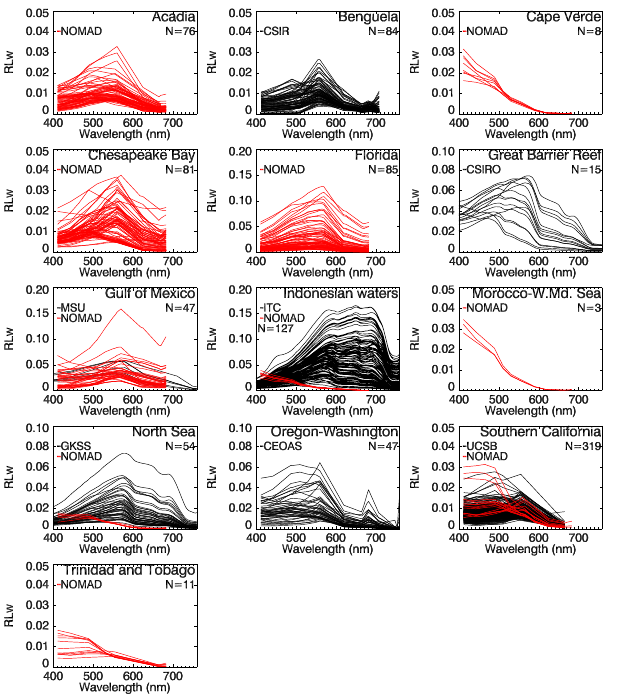
Figure 18. Match-up field RLw provided from 13 CoastColour sites by the eight data providers indicated in the figures. Note the different scales used for the sites.